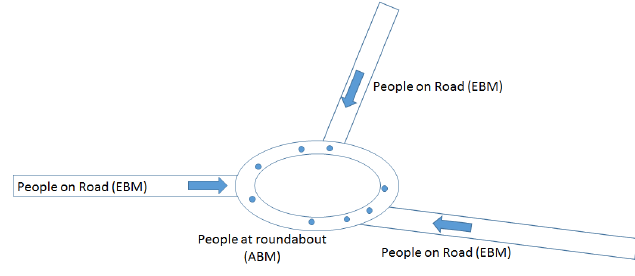
Figure 1. Coupling approach example: people moving on the road are represented in the form of equation, and in form agents at the crossroads